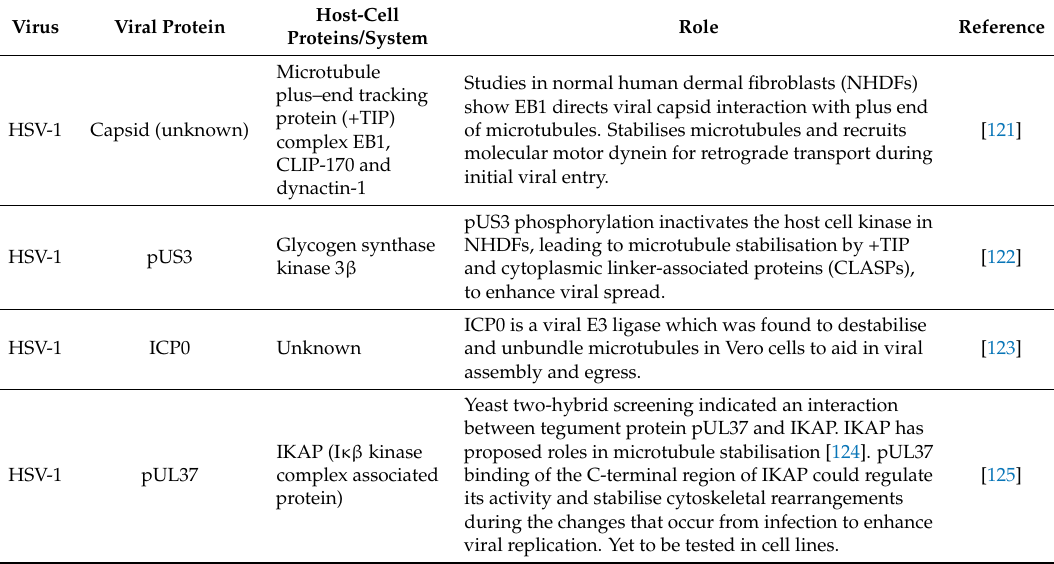
Table 3. Alphaherpesvirus-host interactions that regulate microtubule